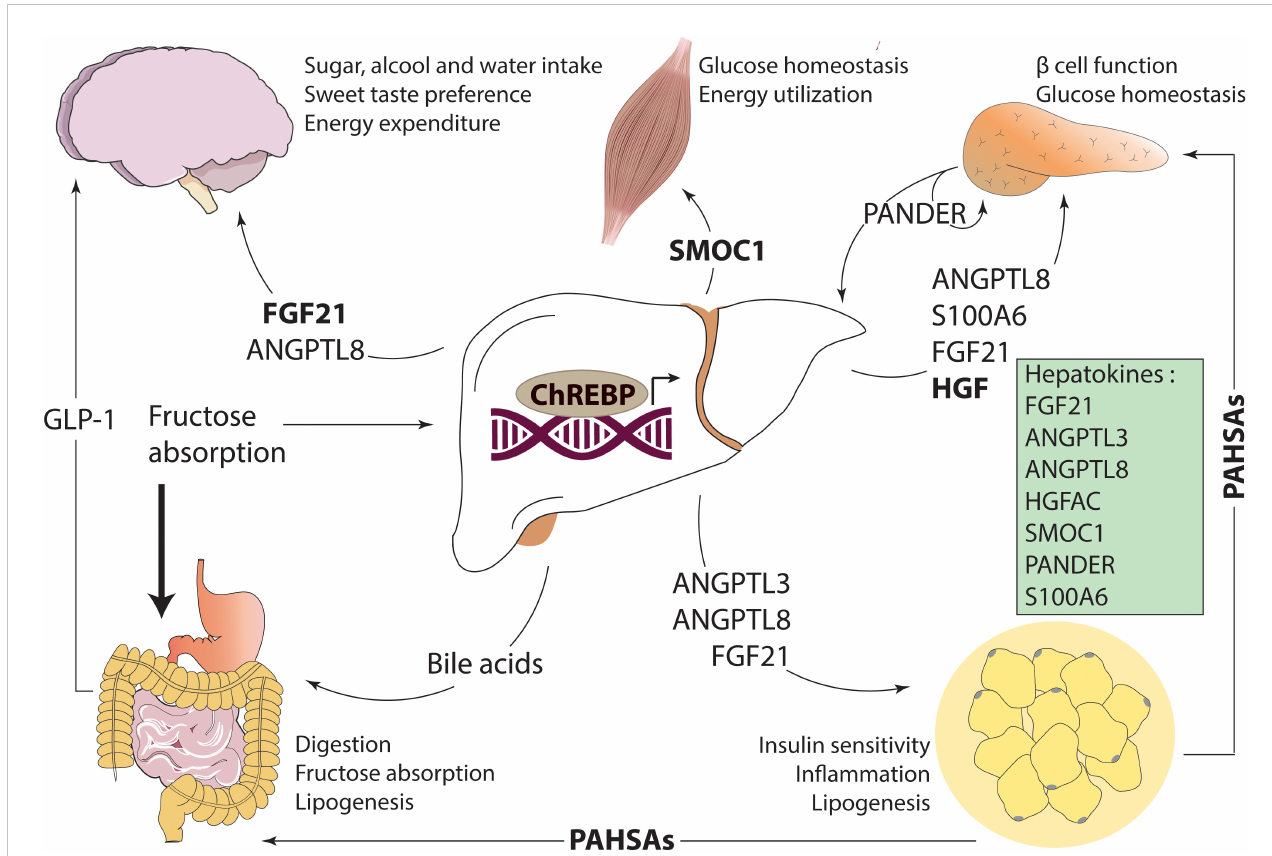
FIGURE 1 In health, ChREBP drives inter-organ communication through the regulation of different signaling factors in response to glucose and fructose. In the liver, ChREBP promotes the production of bile acids which are released in the intestine facilitating digestion and improving glucose homeostasis by GLP-1. ChREBP activity also triggers hepatokine secretion, such as FGF21, ANGPTL3, ANGPTL8, HGFAC, PANDER, SMOC1 and S100A6. These hormones reach their target tissues via the circulation and acts in speci fi c tissues to regulate metabolic homeostasis. Finally, adipose ChREBP improves local and systemic insulin resistance by releasing